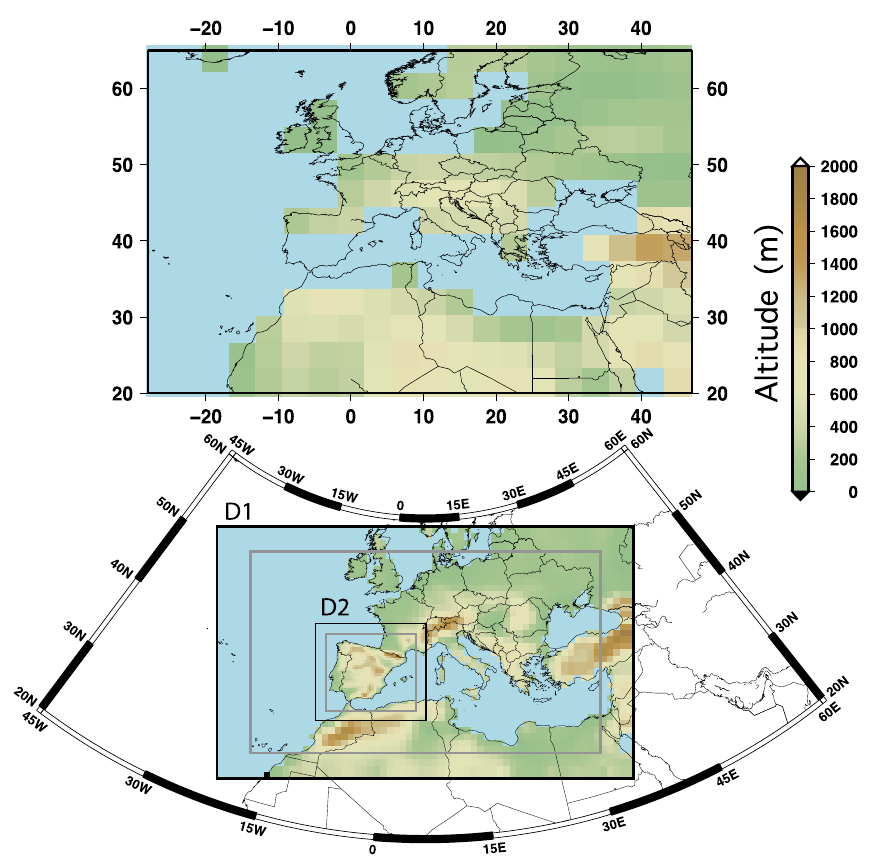
Fig. 2. Land-sea mask and orography of the AOGCM simulation (top) and spatial configuration of the two 2-way nested domains of 90 and 30km respectively used in the RCM simulation (bottom). The colour of the squares in both figures represent the topography implemented in the models. Blue squares represent ocean grid boxes. Only the area inside the grey square in domain 2 (D2) is analysed hereafter.